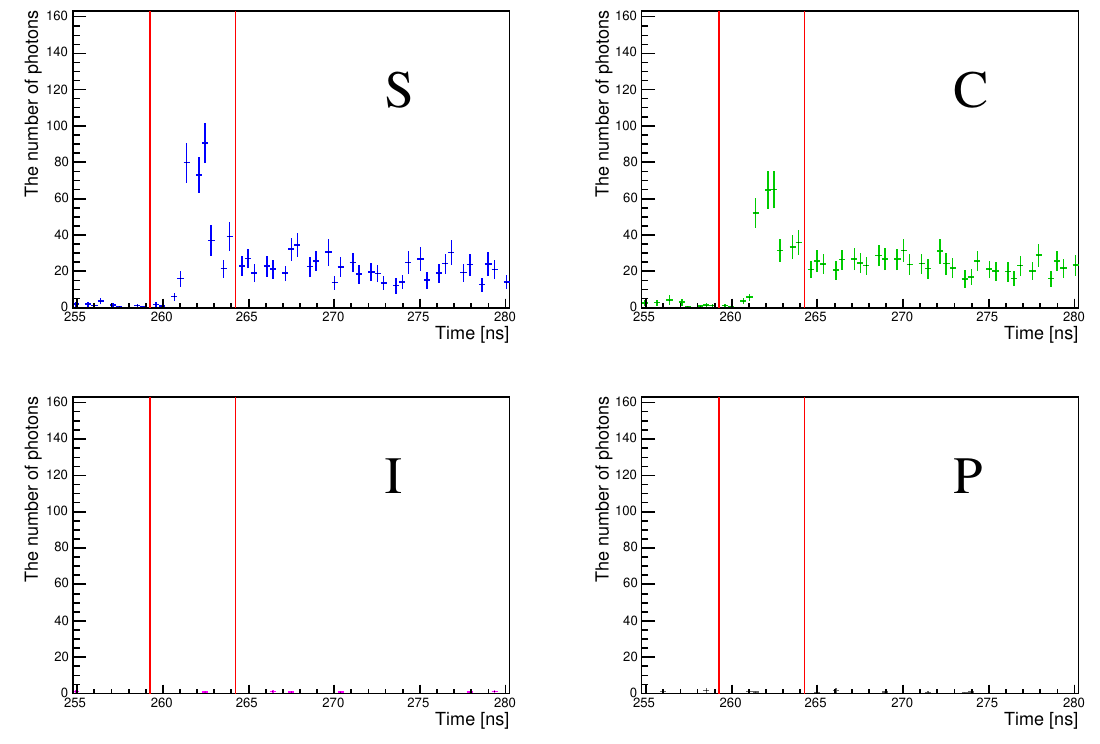
Figure 7 . Arrival-time distributions of number of observed photons by combining the P- polarization state (creation) and the left-handed circular polarization state (inducing) for individual trigger patterns at 10 Pa. The individual time windows in which signal photons are expected to be detected are indicated with the two red